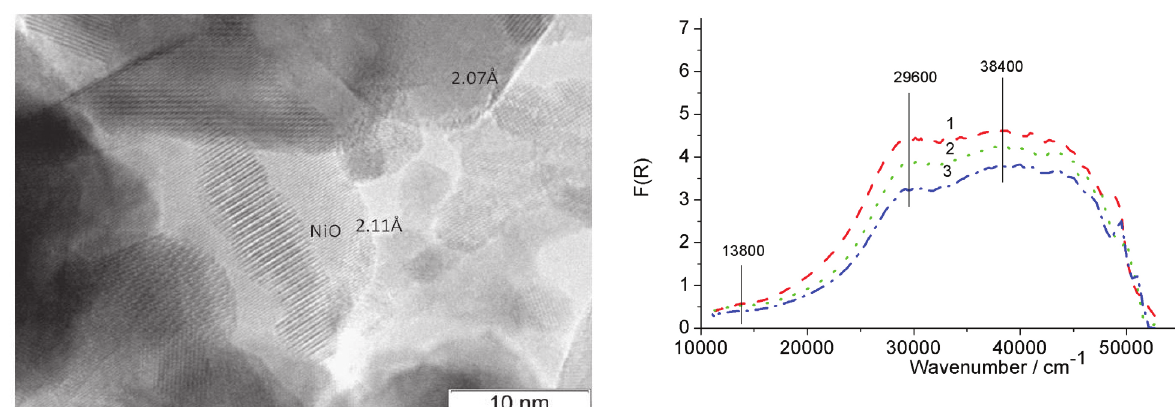
Figure 9: Raman spectra of Ce-Zr-O samples with Ce/Zr ratio 1/1 and 7/3.